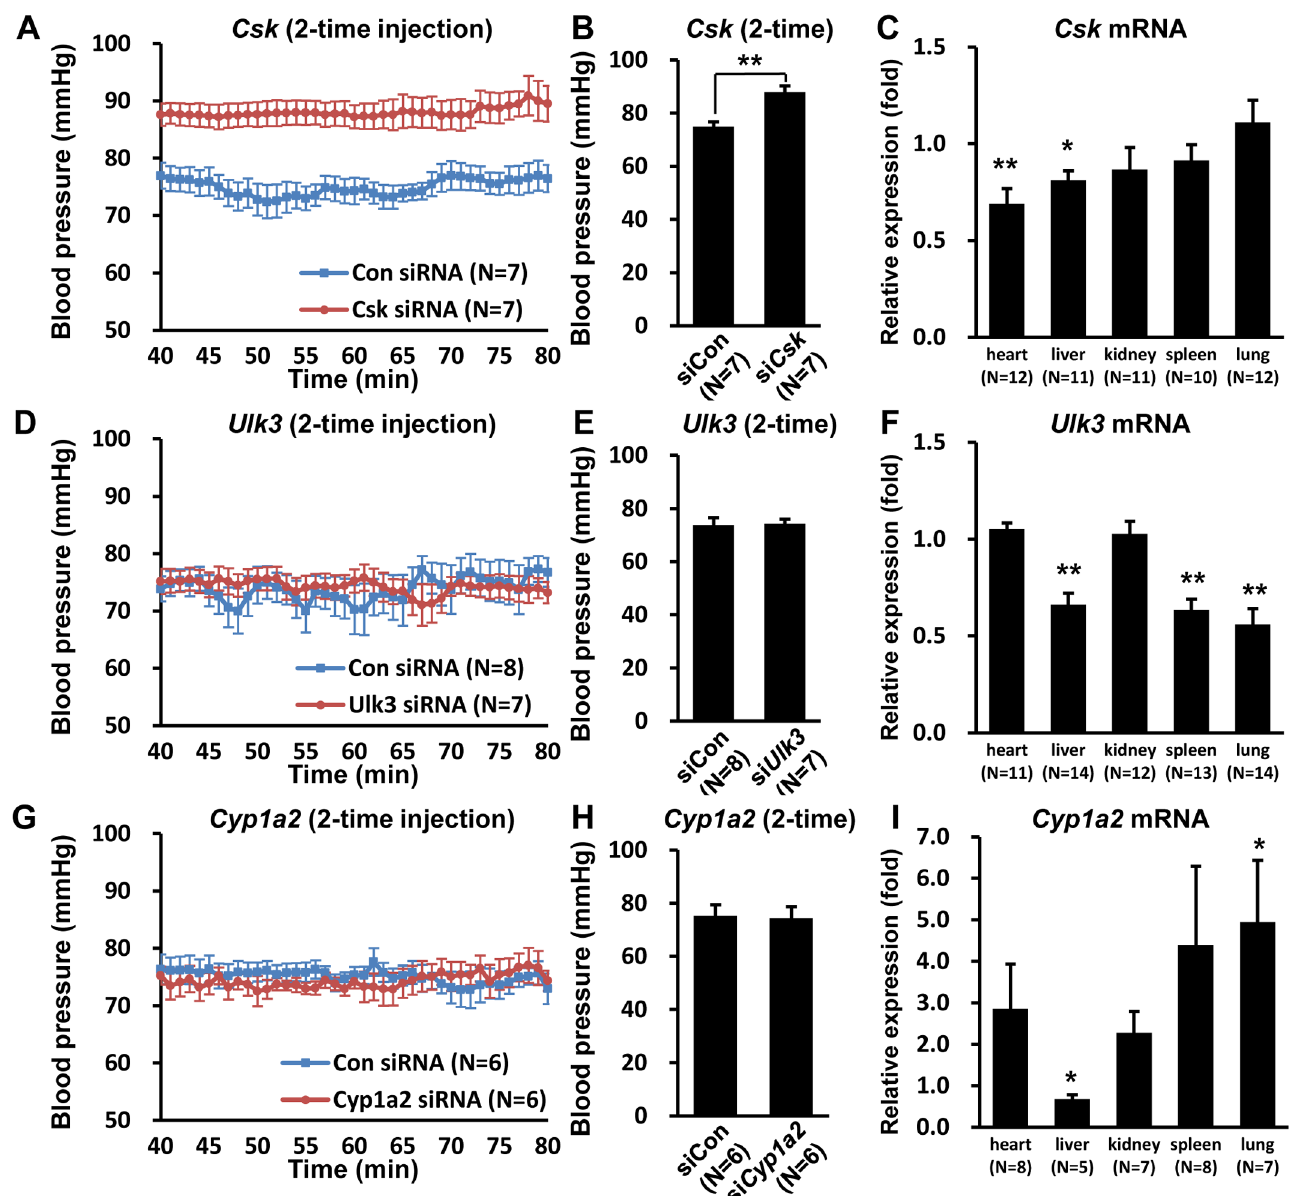
Fig 2. Increase in blood pressure in Csk siRNA-injected mice. (A, D, and G) The line graph shows blood pressure as the average value at each minute from 40 min to 80 min after anesthesia in (A) 2- time Csk siRNA-, (D) 2-time Ulk3 siRNA-, and (G) 2-time Cyp1a2 siRNA-injected mice. (B, E, and H) The bar graph shows the mean blood pressure for each group from 40 min to 80 min. (C, F, and I) Graphs show the relative expression of candidate gene mRNA in each tissue after 2-time siRNA injection. * P < 0.05, ** P < 0.01 versus respective